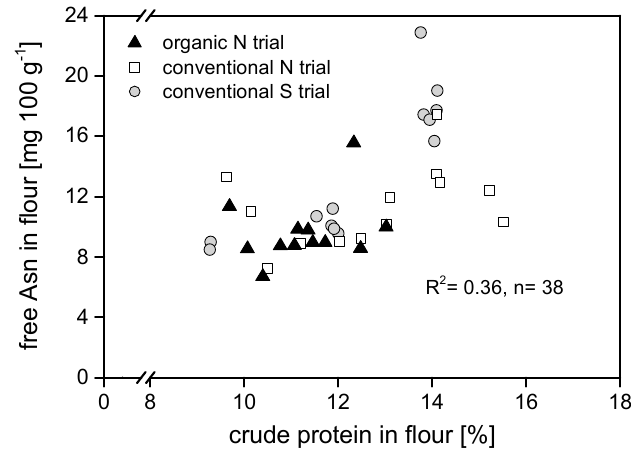
Figure 4. Correlation of crude protein and free Asn of winter wheat, separated by trial.